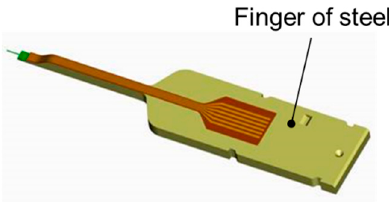
Figure 38. Microprobe on steel finger carrier developed in the course of µgeoMess, a BMBF funded project [13].